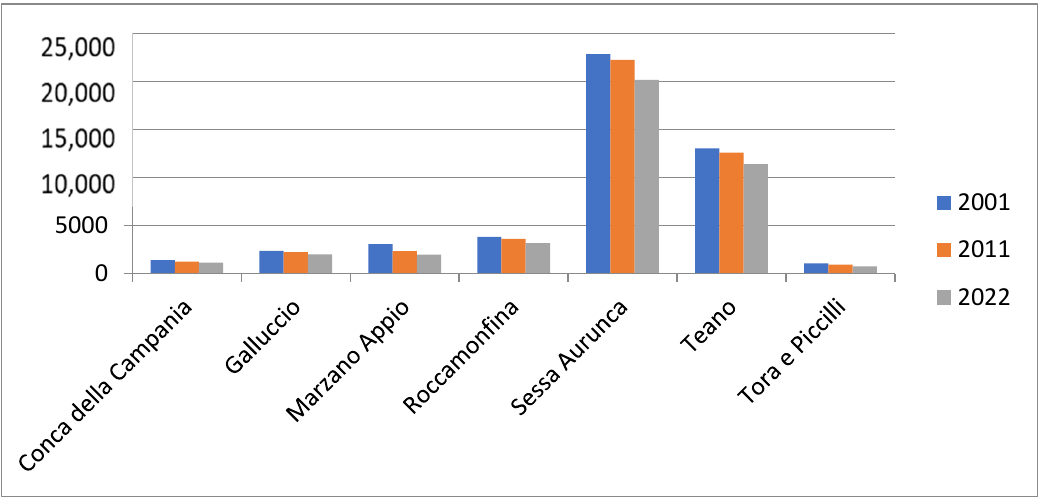
Figure 6. The graph effectively visualises the scale of depopulation and, consequently, the importance of the phenomenon, which particularly affects areas with a high landscape and cultural value that are poorly developed (elaboration by Antonio Bertini on Istat data).